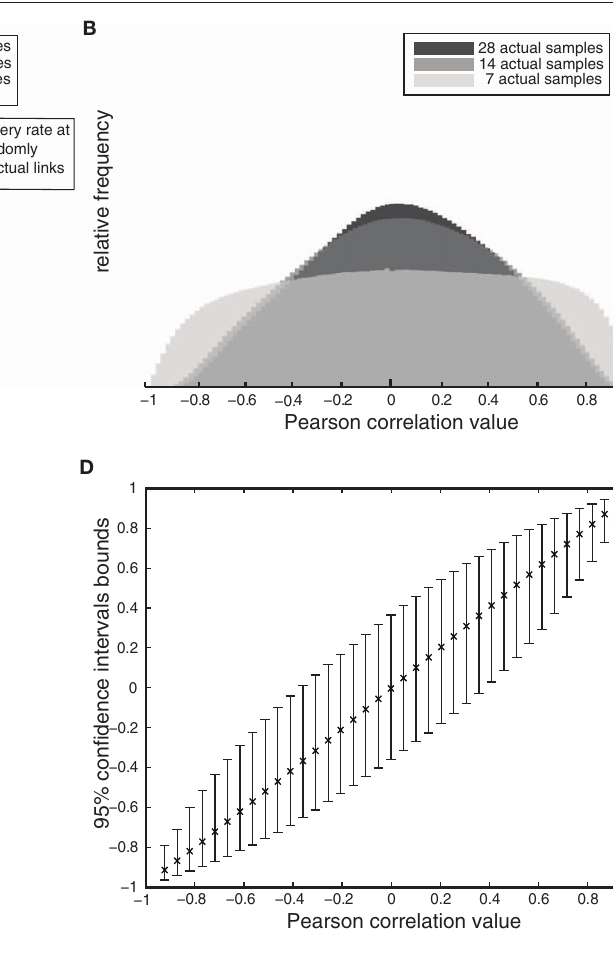
between n = 14 and n = 28 samples. (C) Example estimates of network synchronizability (low synchronizability implies high modularity) at various thresholds in order to optimize correlation cutoff (example estimates based on different subsets of nodes are shown in different colors). Inset: schematic of link pruning and changes in modularity shown for increasing cutoffs. (D) 95% confidence bounds on Pearson correlation values (estimated by resampling) later employed in testing for differential